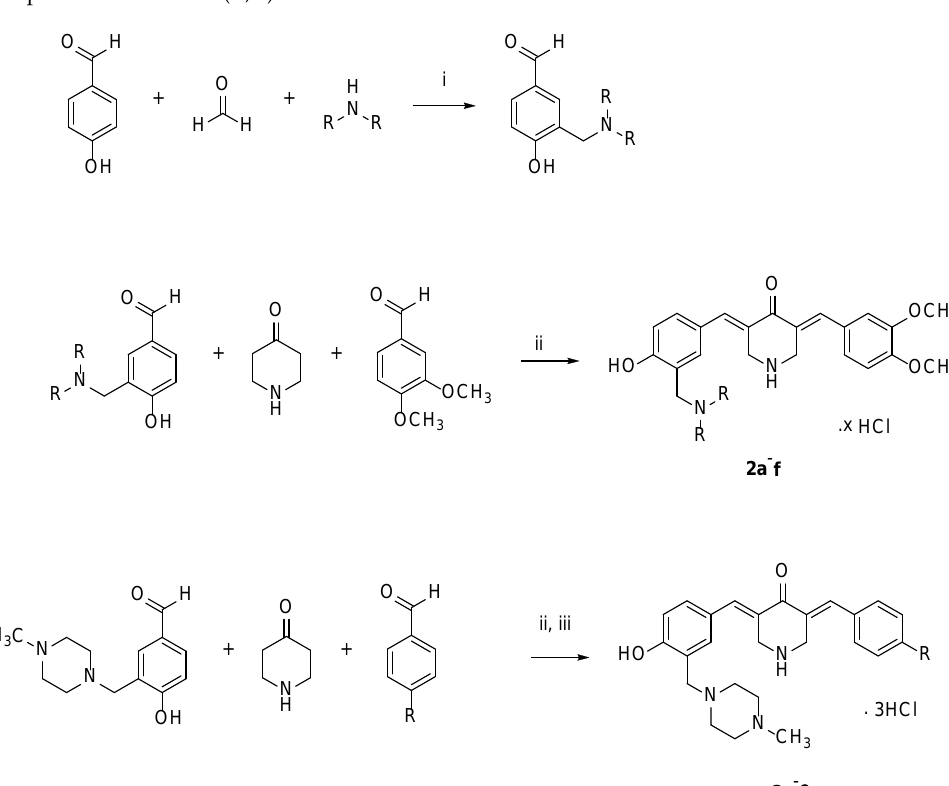
Table 5. Plots between the average SI values in Tables 1 and 2 and the differences between the atomic charges on C A and C B